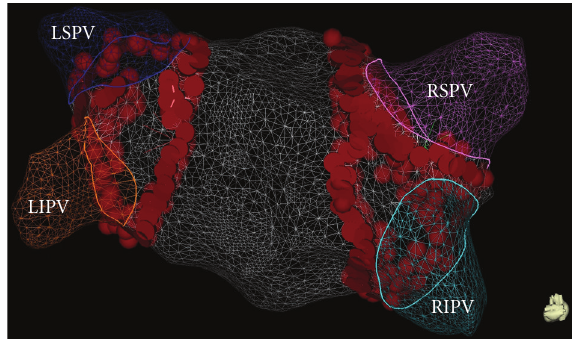
Figure 1: Three-dimensional reconstruction of the left atrium using the CARTO 3 map system (Biosence Webster, USA) showing large circumferential ablation lesions around both ipsilateral veins. In this example, additional radiofrequency energy was applied on the interpulmonary isthmus following the large circumferential lesion creating a “figure of eight” model. LSPV: left superior pulmonary vein; LIPV: left inferior pulmonary vein; RSPV: right superior pulmonary vein; RIPV: right inferior pulmonary